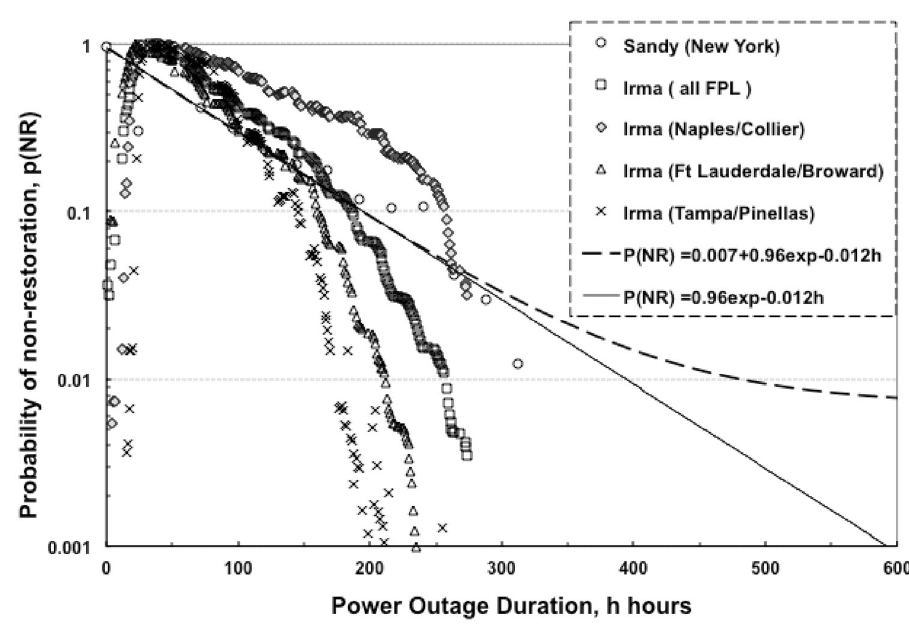
Fig. 4 Regional variations